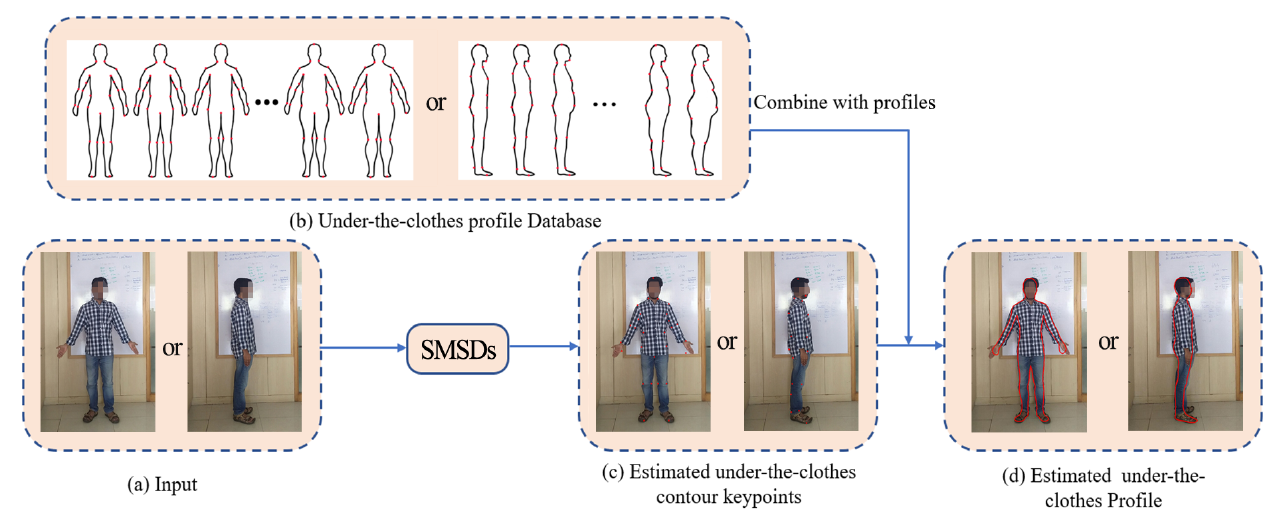
Figure 4. Overview of our DeepProfile. Given the input front- and side-view images ( a ) and a human profile database ( b ), the body contour keypoints are estimated ( c ) to generate the human body profile ( d ). Here, we employ a CNN with SMSD blocks to estimate contour keypoints and compare the difference among them and relevant feature points in profile database, then we interpolate the most similar profiles to synthesize the under-the-clothes profile. Images of different views are trained